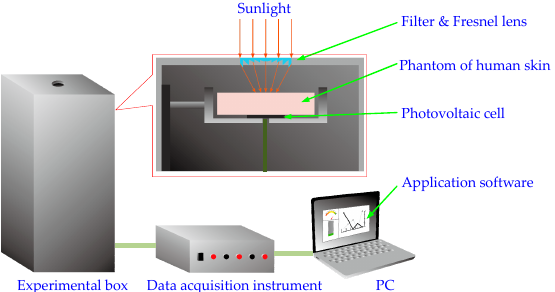
Figure 9. Experimental device of the recharging method of implantable biosensors based on solar radiation.